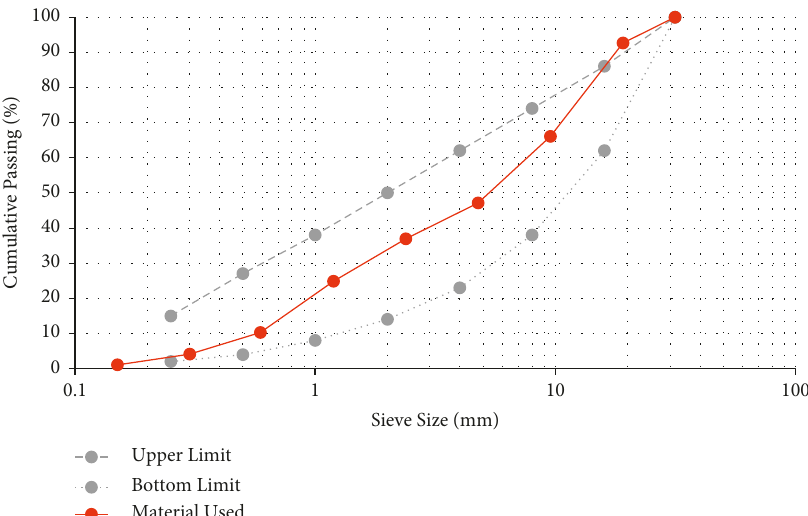
Figure 3: The gradation of concrete-CA material